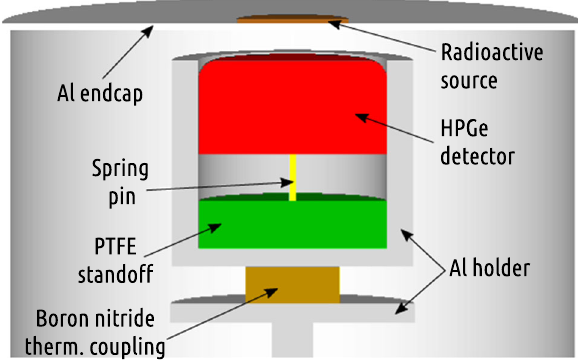
Fig. 12 Detector-cryostat geometry as implemented in GEANT4. The detector holder, as well as the PTFE standoffs and the readout pin, are all taken into account in the simulation. Radioactive sources are placed on top of the aluminum endcap